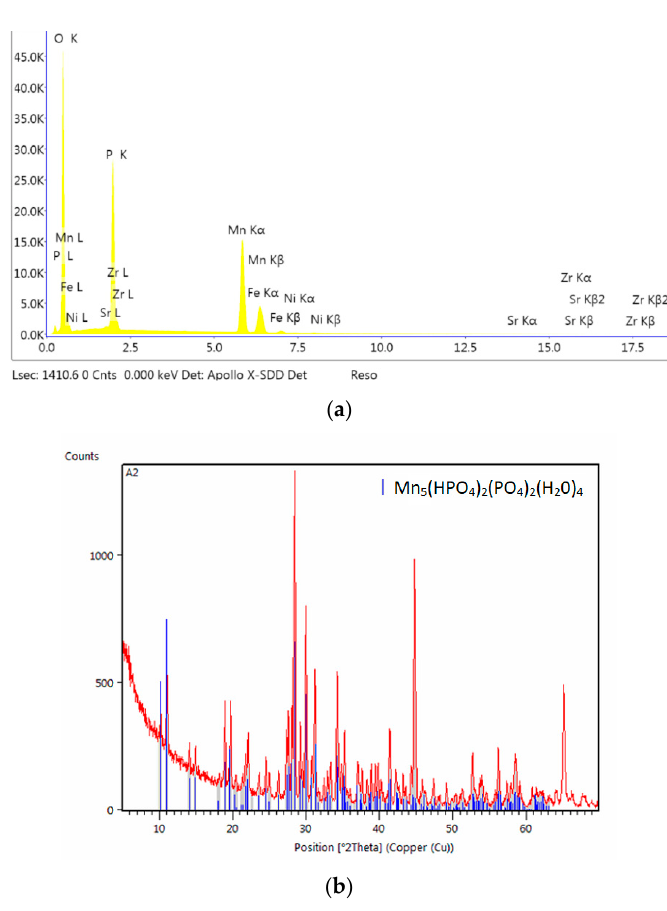
Figure 10. EDS ( a ) and XRD spectra ( b ) of the sample modified with strontium.